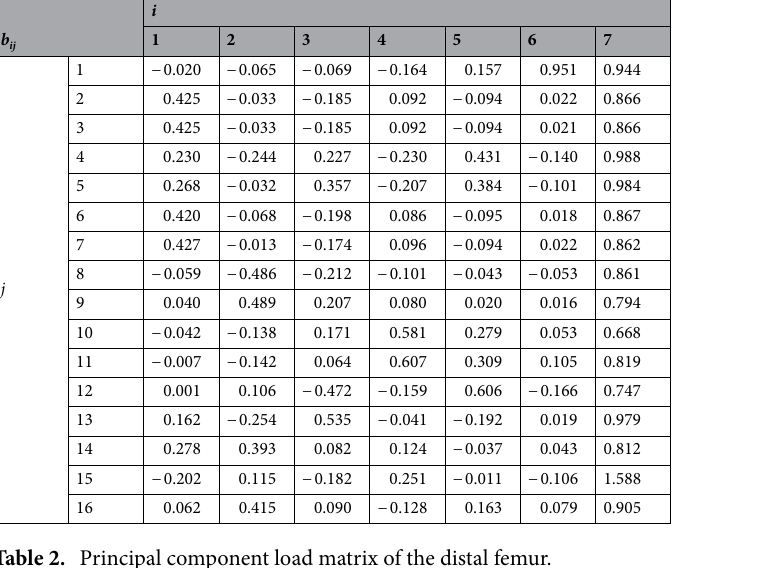
Table 2. Principal component load matrix of the distal